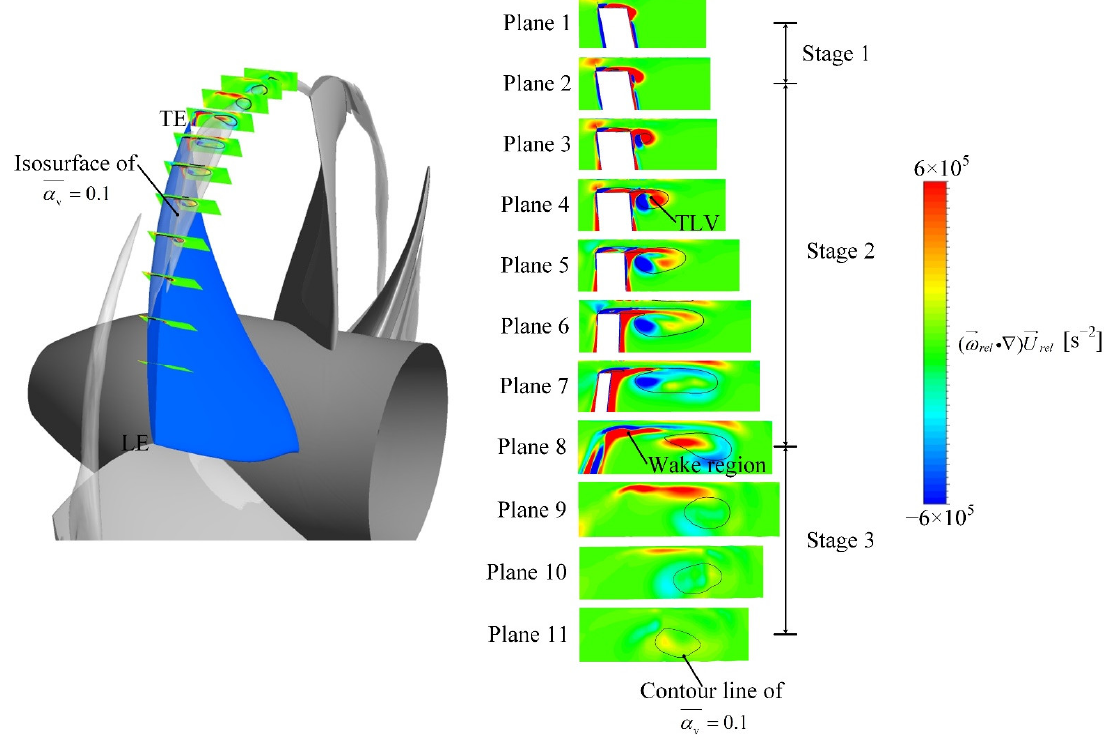
Figure 8. Vortex stretching-and-bending term.